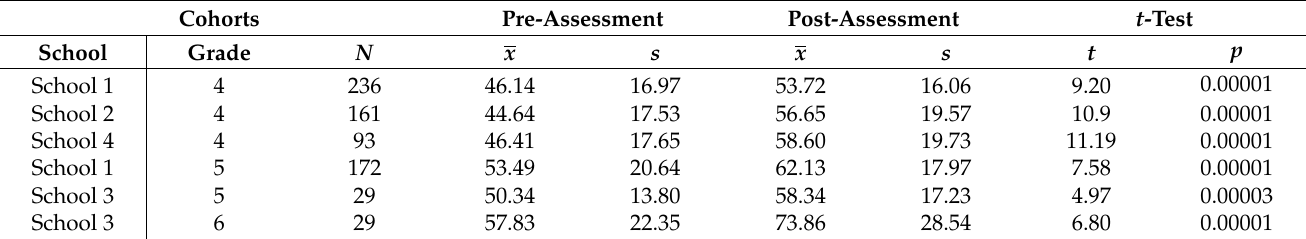
Figure 4. Distribution of the fluency assessment results. Table 4. Statistical analysis of participants’ pre- and post-assessment results.